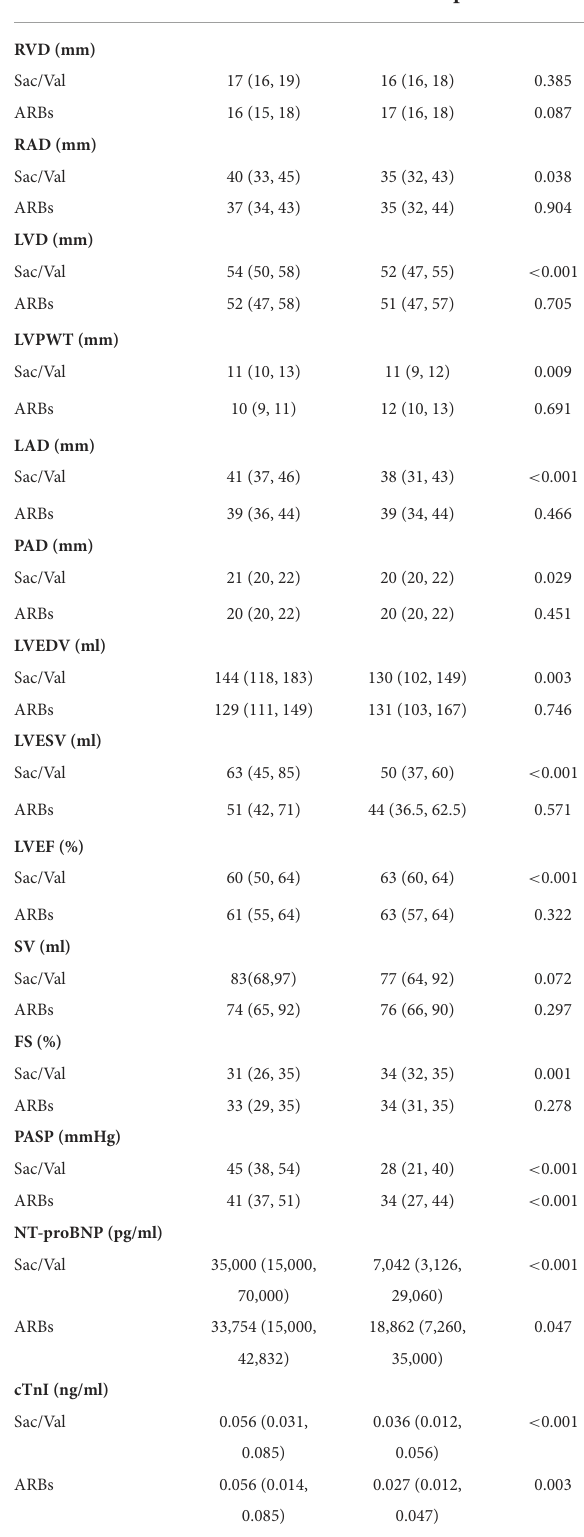
TABLE 2 Echocardiographic parameters and cardiac biomarkers at baseline in two groups. Parameters